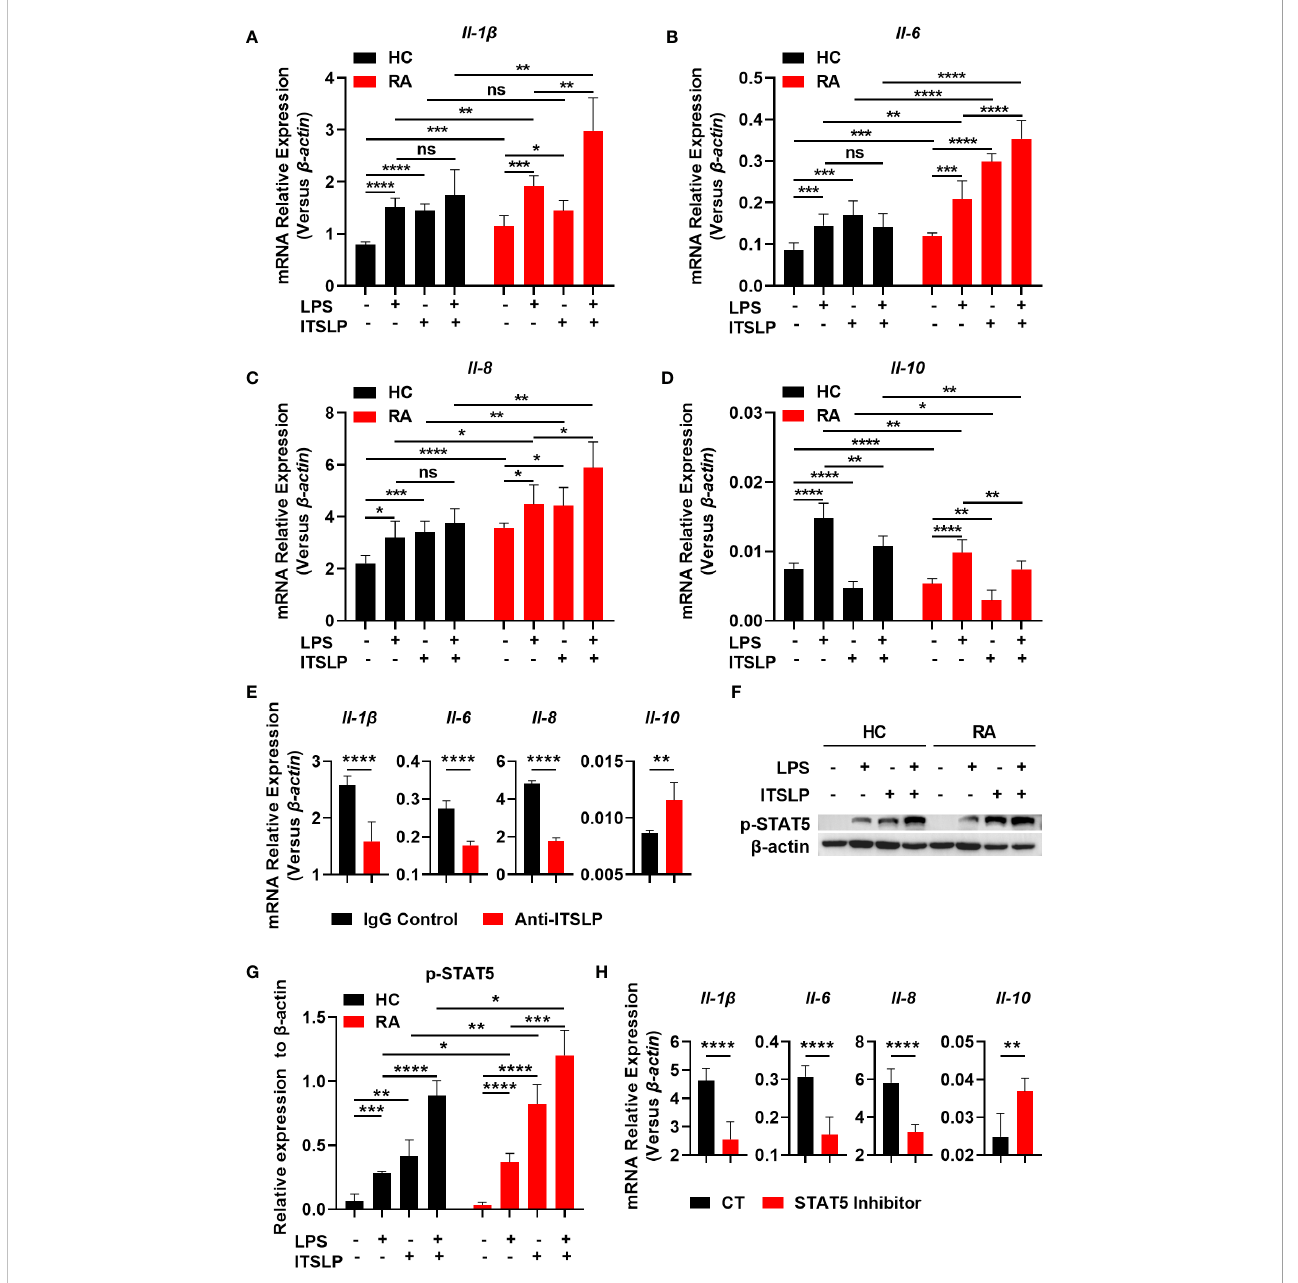
FIGURE 4 lTSLP induces pro-in fl ammatory cytokine expression in PBMCs by triggering STAT5 activation. (A-D) PBMCs from RA patients and healthy controls (HC) were cultured for 24h with or without LPS (100 ng/mL) or lTSLP (100 ng/mL). Relative mRNA levels of Il-1 b (A) , Il-6 (B) , Il-8 (C) and Il-10 (D) were analyzed by RT-qPCR. (E) PBMCs from RA patients were treated 24h with 0.25 µg/ml anti-TSLP neutralizing antibody or an IgG antibody control, and the relative mRNA levels of Il-1 b , Il-6 , Il-8 , and Il-10 were analyzed by RT-qPCR. (F) PBMCs from HC and RA were stimulated with 100 ng/mL LPS in the presence or absence of 100 ng/mL lTSLP for 1h. Western blots to examine the expression level of p-STAT5, normalized to b -actin. Relative p-STAT5 expression was quanti fi ed in (G) . (H) PBMCs from RA patients were treated with 50 m M STAT5 inhibitor 1h before being stimulated with LPS (100 ng/mL) and lTSLP (100 ng/mL) for RT-PCR detection of Il-1 b , Il-6 , Il-8 , and Il-10 mRNA expression. P values were measured by unpaired two-tailed Student ’ s t- test. *P < 0.05, **P < 0.01, ***P < 0.001, ****P < 0.0001. ns, no signi fi cant. Error bar represent standard